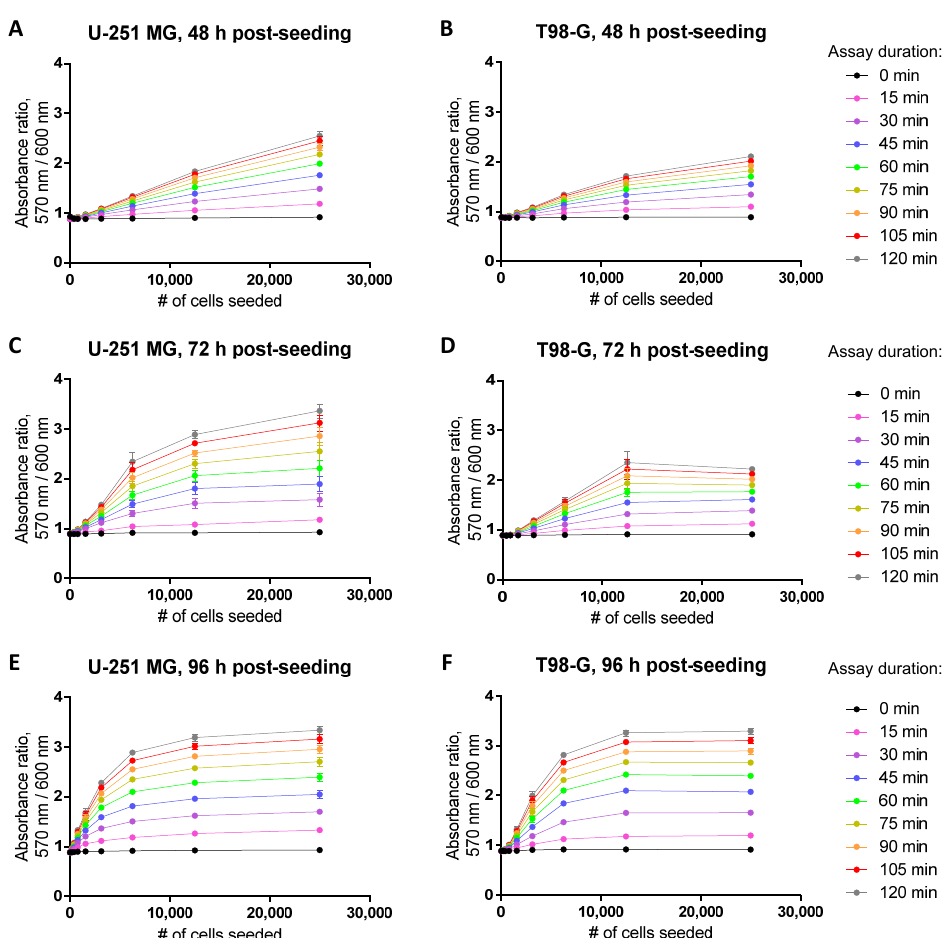
Figure 4. Establishment of the dynamic range in the resazurin assay for glioblastoma cell lines U-251 MG ( A , C , E ) or T98-G ( B , D , F ) at 48 h ( A , B ), 72 h ( C , D ), or 96 h ( E , F ) post-seeding. Detected optical characteristic: absorbance ratio (570 nm/600 nm). All experiments were carried out in the 96-well plate format at 50 µ M resazurin (incubation times with resazurin indicated in the legend on the right). In each graph, an average of triplicates ± SEM from a single representative experiment is shown.